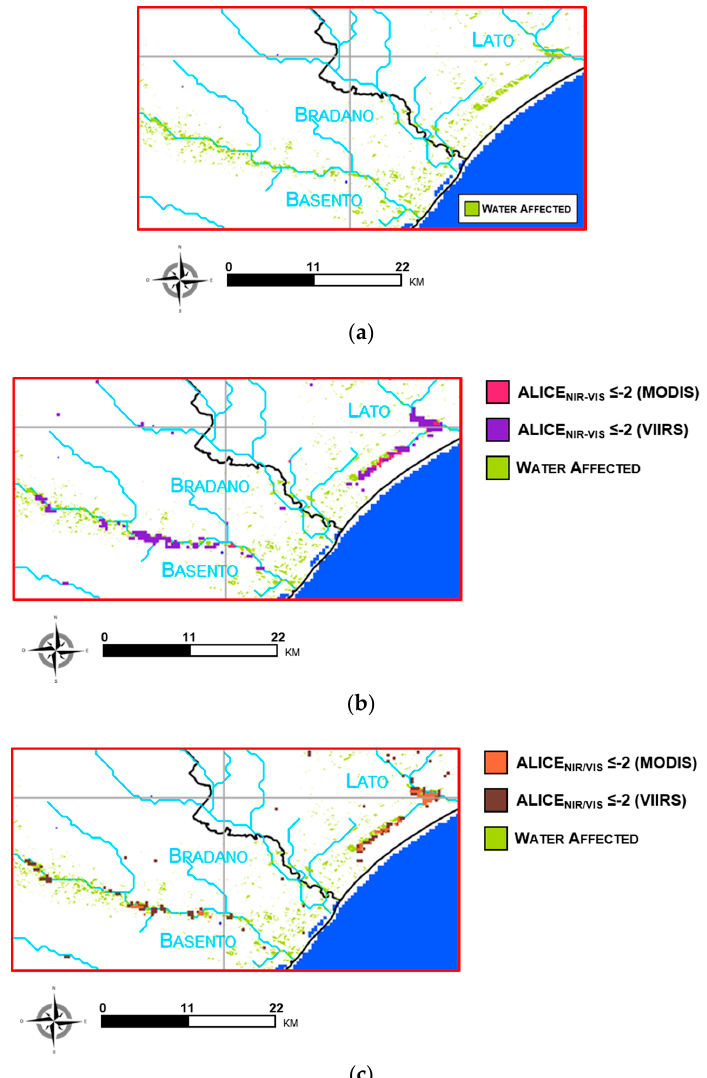
Figure 7. ( a ) Subset of the image shown in Figure 2 highlighting water affected pixels; ( b ) anomalous pixels detected by ALICE NIR-VIS on 5 December 2013 at 11:30 GMT for MODIS (pink) and at 11:52 GMT for VIIRS (violet); ( c ) anomalous pixels detected by ALICE NIR/VIS on 5 December 2013 at 11:30 GMT for MODIS (orange) and at 11:50 GMT for VIIRS (brown).